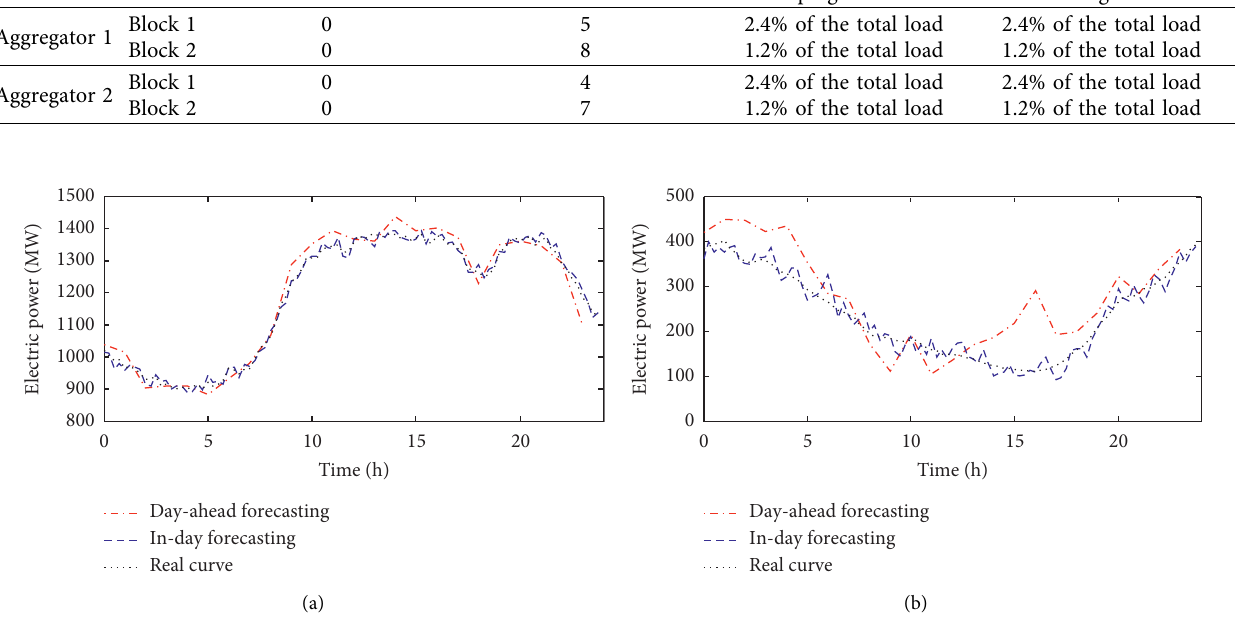
Figure 2: Forecasted curve of load and wind power: (a) forecasted load; (b) forecasted wind power.